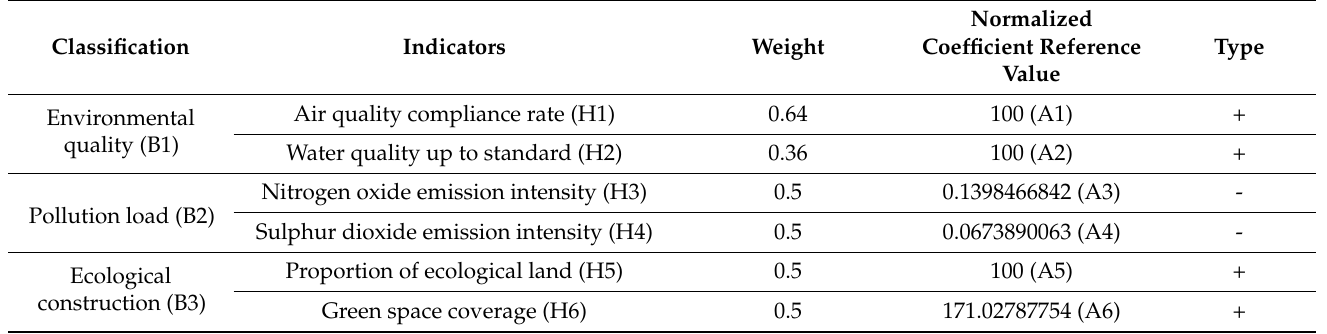
Table 2. Urban ecological environment quality evaluation index system.